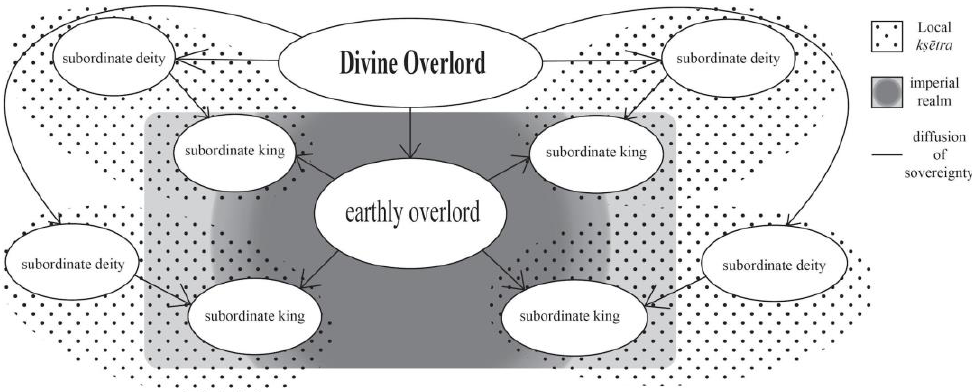
Figure 2. New model of the diffusion of authority and sovereignty 33 .